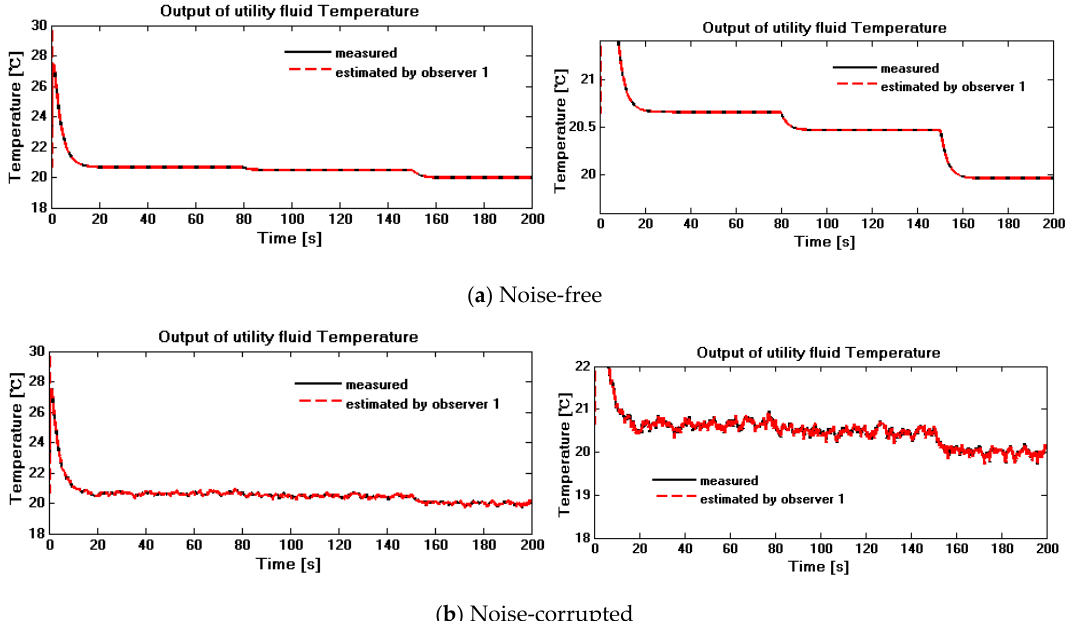
Figure 8. Outlet temperature of the utility fluid T u . The solid line is the measured value, and the dashed line is estimated by Observer 1. ( a ) represents Noise-free case while ( b ) represents Noise-corrupted case.